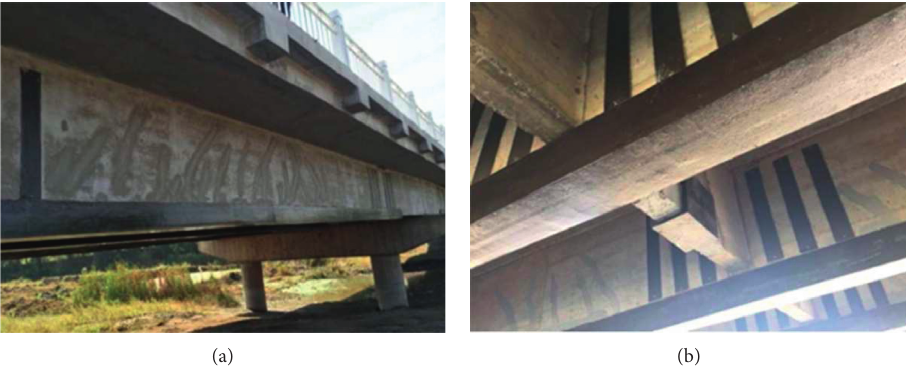
Figure 1: Case of solid bridge reinforcement. (a) Overall effect. (b) Beam bottom